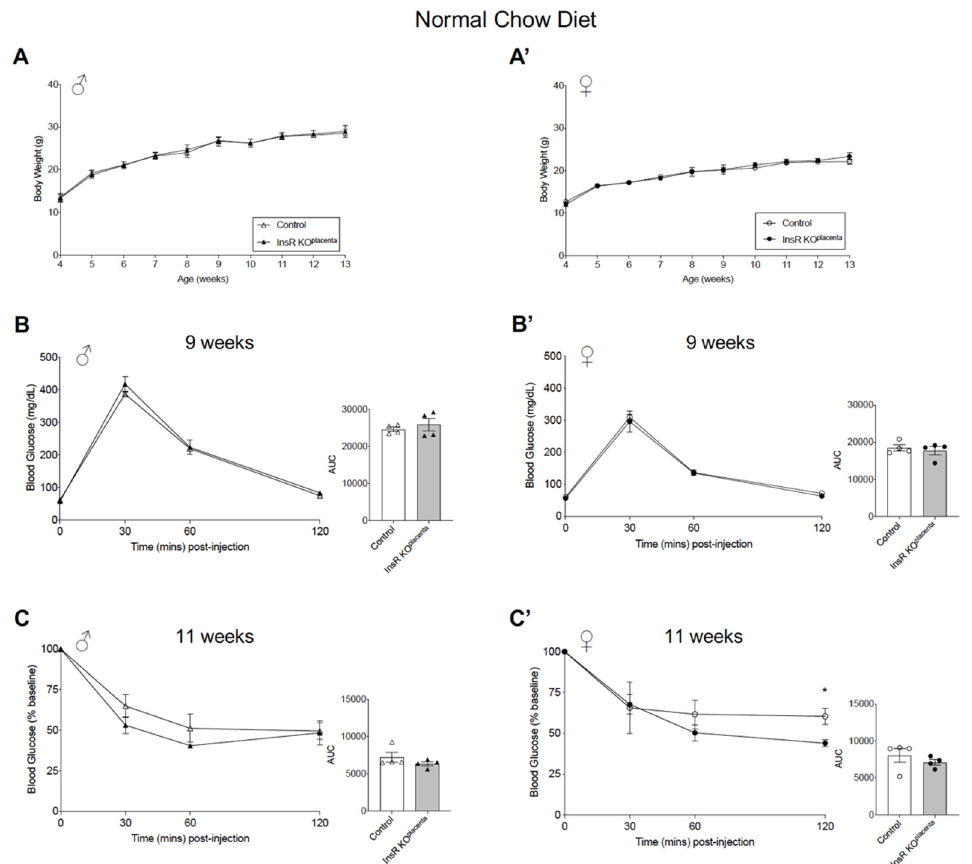
Figure 2. Adult InsR KO placenta mice displayed normal glucose homeostasis on a normal chow diet. ( A ) Body weight in all the males ( n = 9, 10) and ( A’ ) the female ( n = 13) InsR KO placenta and control mice on a normal chow diet. Body weight for the offspring presented as combined data from parity ≥ 3 and ≤ 2 litters. ( B ) IPGTT and AUC analysis (right) for the male ( n = 4) and ( B’ ) female ( n = 4) mice from parity ≥ 3 on a normal chow diet at 9 weeks of age. ( C ) IPITT and AUC analysis (right) for the males ( n = 4) and ( C’ ) females ( n = 4) from parity ≥ 3 at 11 weeks of age. Blood glucose values for IPITT are expressed as the baseline percentage of blood glucose. The values are reported as the means ± SEM, * p < 0.05.